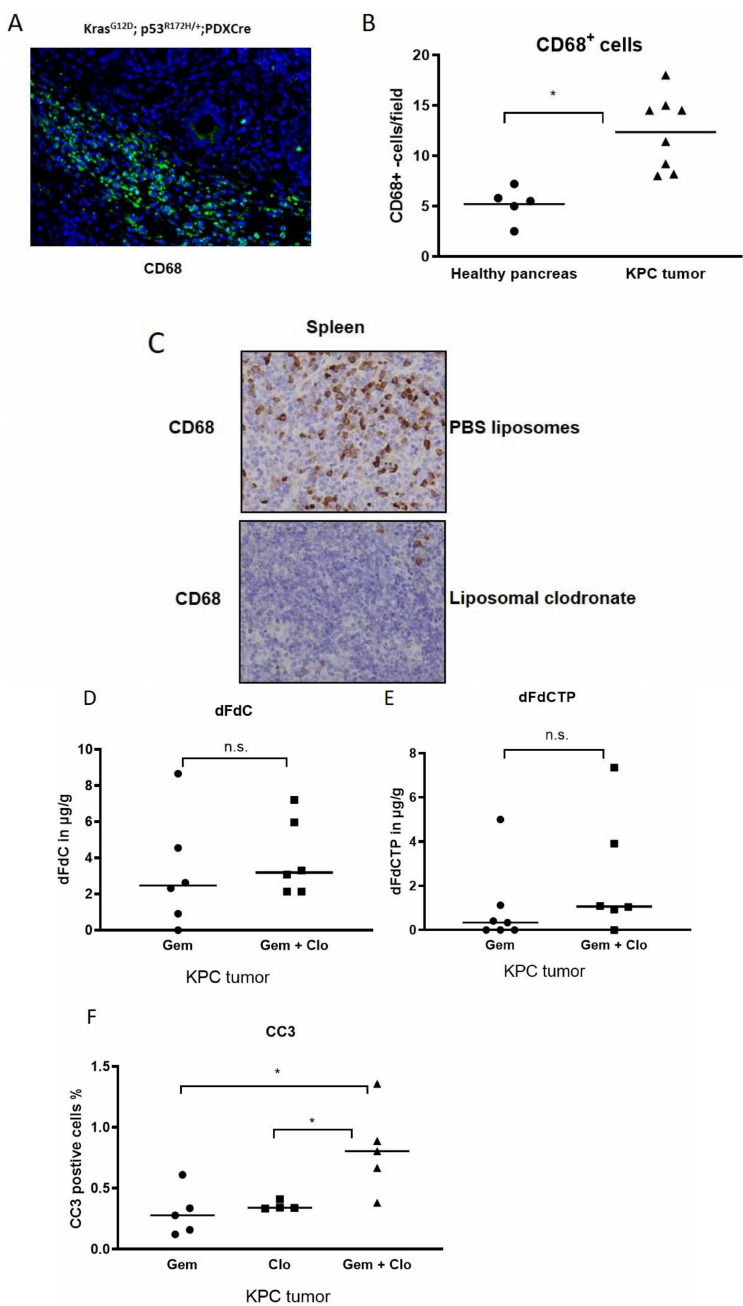
Figure 4. ( A ) Immunofluorescence of a KPC tumor showing dense infiltration of CD68 + macrophages (green) in the tumor microenvironment. ( B ) Manual quantification of CD68 positive cells in healthy pancreata ( n = 5 mice) and KPC tumors ( n = 8) reveals a significant increase in macrophages in tumor tissues ( p < 0.002). ( C ) Representative immunohistochemistry for CD68 in splenic tissue showing robust depletion upon liposomal clodronate treatment. ( D , E ) Tumor biopsies from KPC mice treated with either gemcitabine ( n = 6) or gemcitabine + liposomal clodronate ( n = 6) were assessed for gemcitabine metabolites 2 h after the last injection of 100 mg / kg gemcitabine by LC–MS / MS. Native gemcitabine (dFdC) and the active form of gemcitabine 2’,2’-difluorodeoxyuridine-5’-triphosphate (dFdCTP) were not significantly altered between the two treatment cohorts. ( F ) CC3 immunohistochemistry reveals a significant increase in apoptotic cells in gemcitabine + liposomal clodronate treated KPC tumors compared to gemcitabine alone or liposomal clodronate ( p <